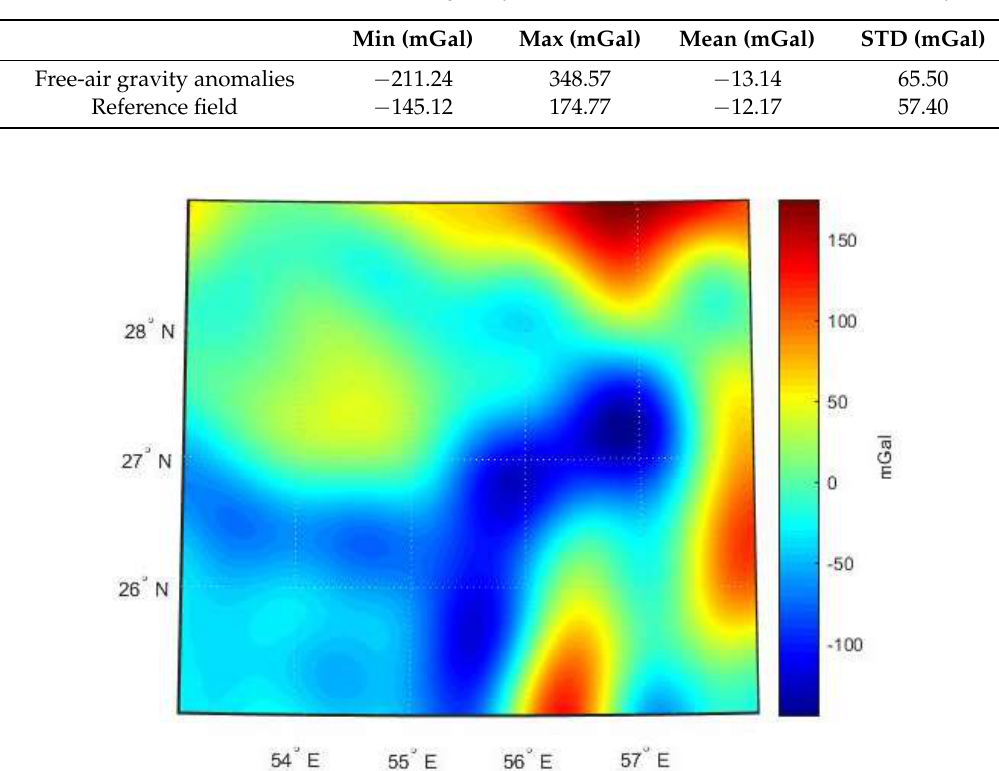
Figure 4. The gravity anomalies computed by EGM2008 up to d/o 360 in the study area (mGal). To find the optimal number of RBFs, as well as their depth below the Bjerhammar sphere, 5% of the input gravity data (1600 points), were excluded from the gravity database. These points were chosen randomly. Different numbers of control points were chosen, and trial and error showed